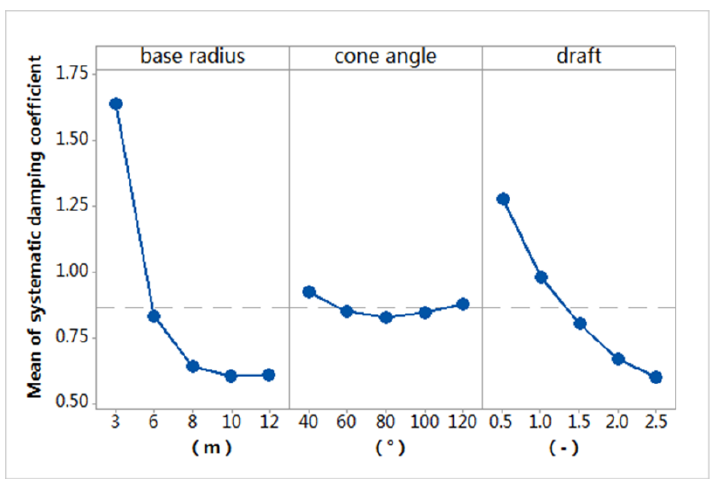
Figure 13. Main effects plot for systematic damping coefficient.